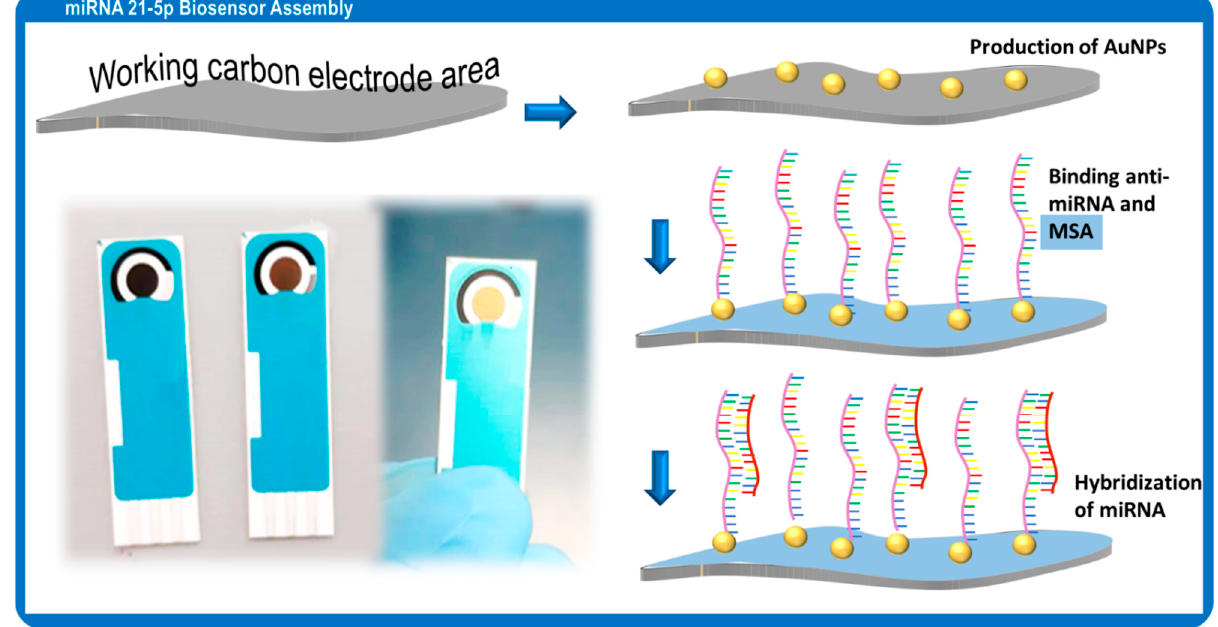
Figure 1. Schematic representation of the assembly of the microRNA 21-5p sensing area on the carbon working electrode and hybridization with the target miRNA.